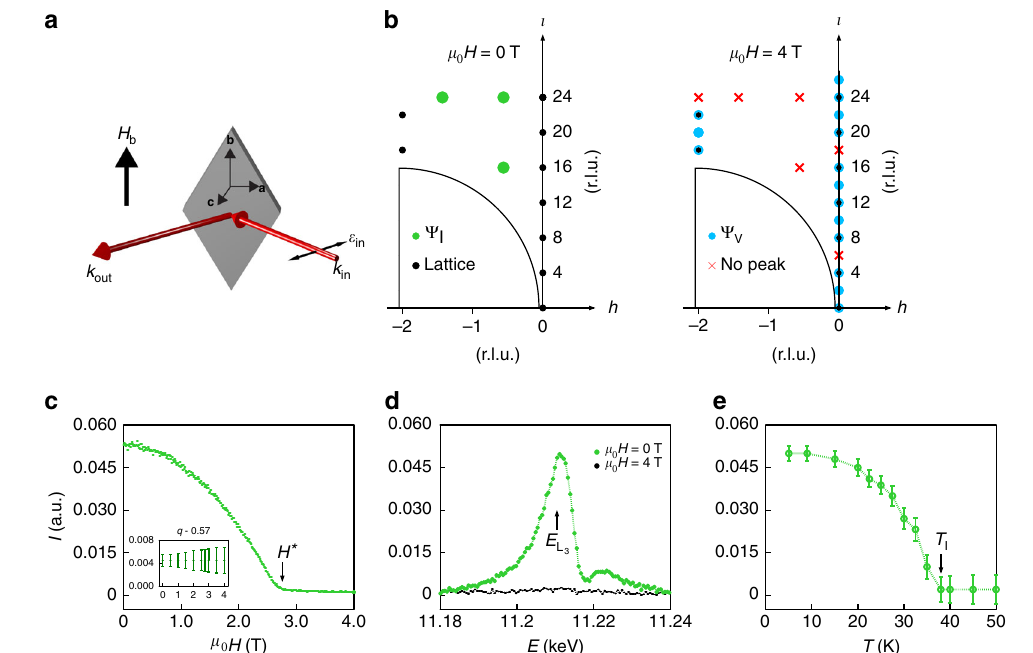
Fig. 2 Fate of the incommensurate order q = (0.574, 0, 0) under an applied fi eld H b . a The scattering geometry used during this experiment showing the polarization of the incoming X-ray beam ( π -polarized) and the direction of the applied magnetic fi eld (along the b — axis). b The two right panels display all the surveyed positions in reciprocal space at H = 0 T (middle panel) and H > H * (right panel). Black dots denote structural peaks, blue dots represent the fi eld-induced commensurate magnetic peaks Ψ Ψ H > H *. V , green dots represent the incommensurate peaks of I , and the red crosses show absent peaks at The semicircles represent an inaccessible region below the sample horizon. c Field dependence of the scattering intensity at T = 5 K showing complete suppression at μ 0 H * = 2.8 T. The inset shows that the q — vector remains constant under an applied magnetic fi eld. d Energy dependence of the scattering intensity at T = 5 K for μ 0 H = 0 and 4 T. e Temperature dependence at μ 0 H = 0 T showing the onset of the order parameter at T I = 38 K. The Gaussian fi t to the integrated RMXS intensity gives the χ 2 uncertainty shown by the error